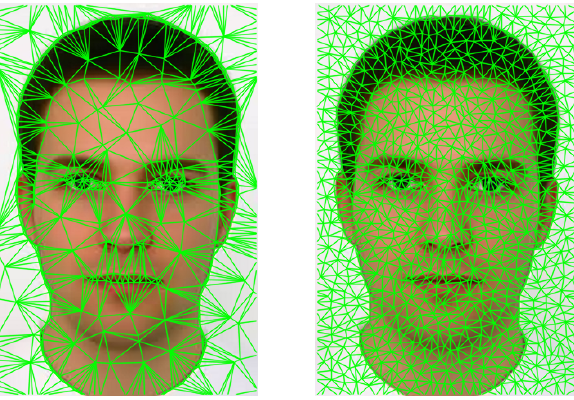
Figure 1. Image decomposition into trianges. Our Delaunay point process generates triangulations whose edges and facets capture the image contours and homogeneous areas